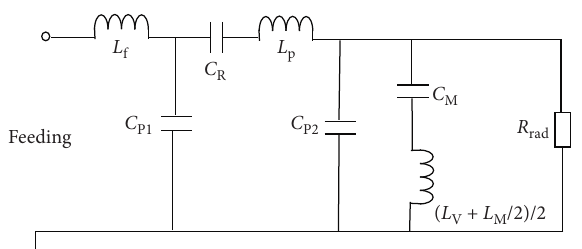
Figure 6: Equivalent circuit of the proposed triband patch